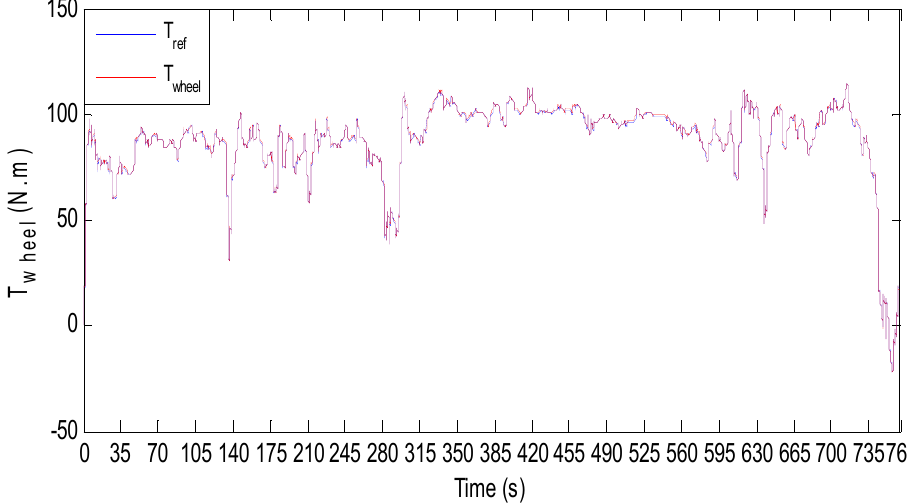
Figure 32. BEV torque response and its reference for HWEFT driving cycle.